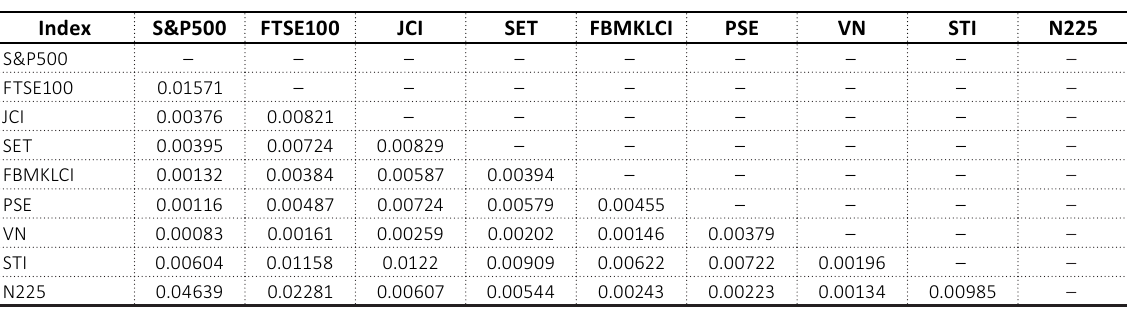
Table 10. Dynamic correlation generalized autoregressive conditional heteroskedasticity (DCC- GARCH(1,1)) estimates (standard deviation of